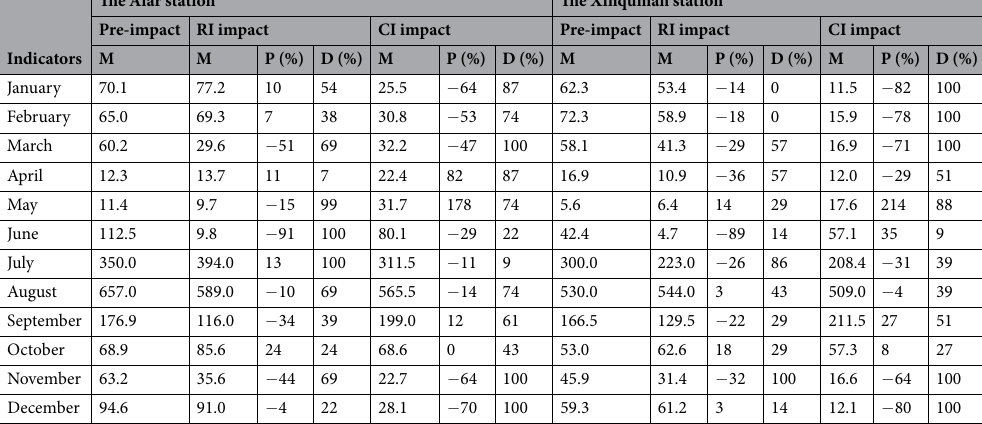
Table 1. Comparison of hydraulic alterations in Group 1 IHAs (monthly streamflow) at the two stations for the pre-impact, RI impact and CI impact. Note: M for median value, P for deviation degree estimated using Equation (1), D for degree of hydrological alteration estimated with Equation (2), RI for Reservoir irrigation, and CI for Channel